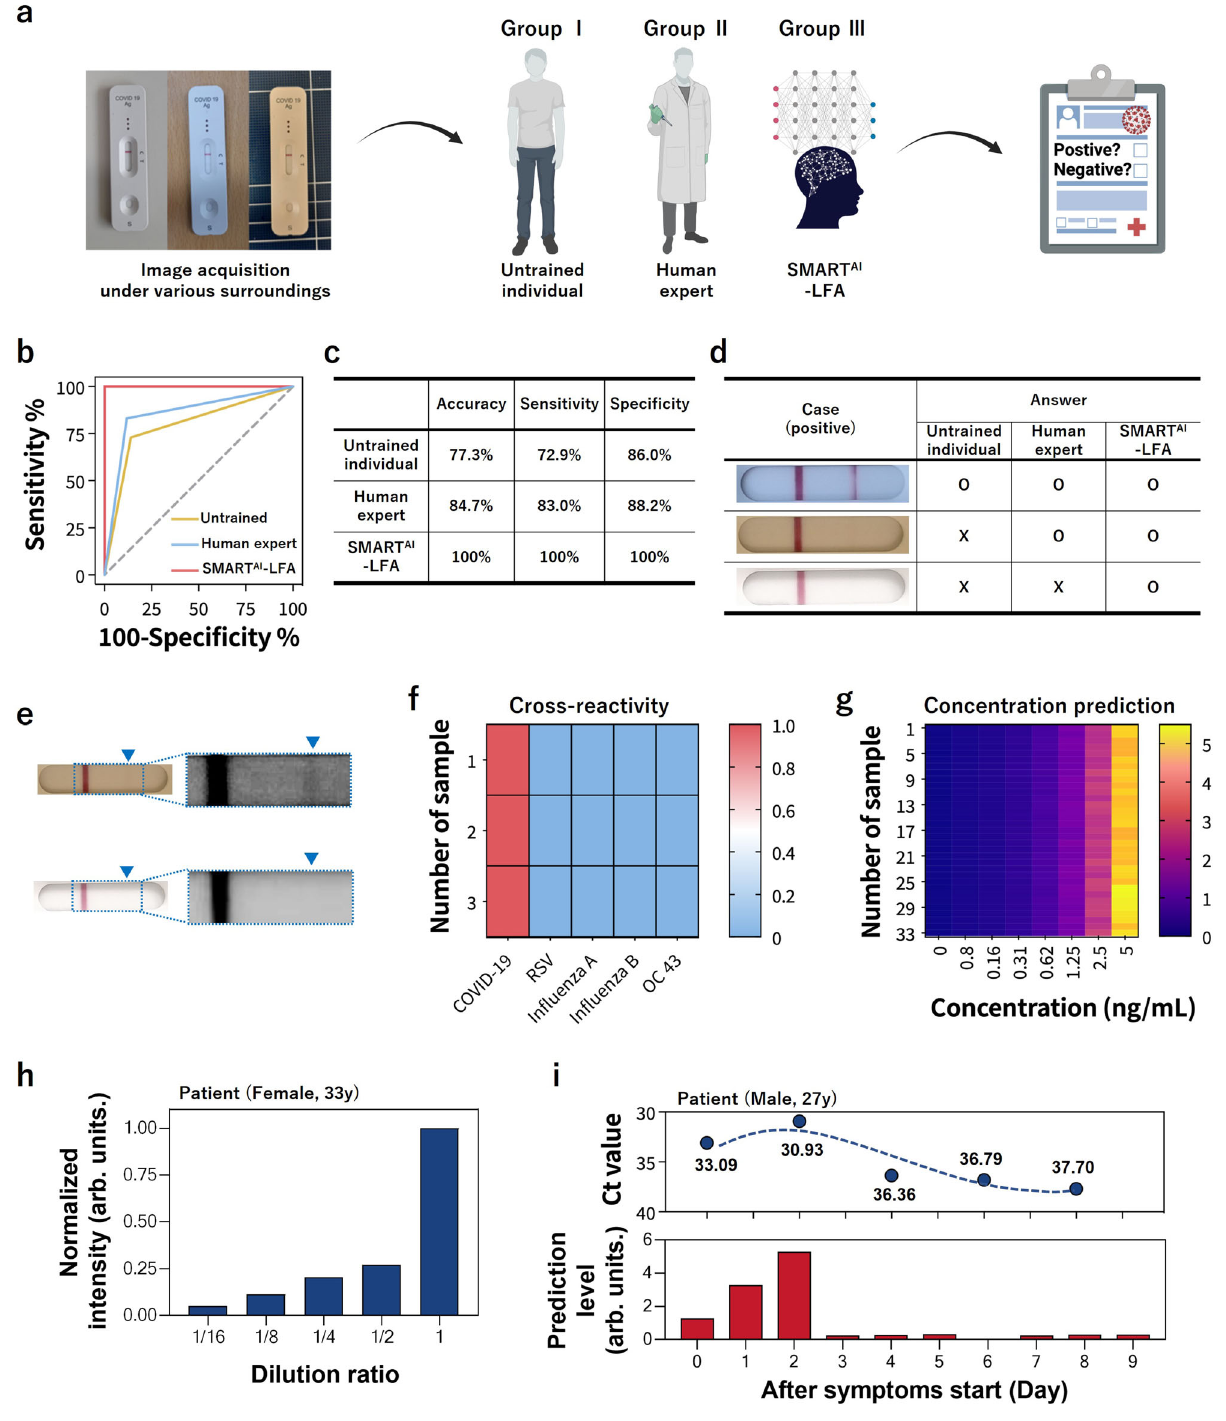
Fig. 3 | Clinical validation via blind tests, cross-reactivity, concentration pre- diction,anddailymonitoring.a – e Blindtest; a Work fl owoftheclinicalvalidation process using a blind test using 1500 test images ( n =1000 patients and n =500 healthy controls). Using SMART AI -LFA, we carried out blind tests ( n =1500) of untrainedindividuals( n =10)andhumanexperts( n =10)every150testimagesand compared it with SMART AI -LFA results, showing great enhancement in sensitivity, speci fi city, and accuracy using a SMART AI -LFA. b The ROC curve and c prediction accuracy. d , e Answers for three positive clinical sample images, clarifying the AI ’ s